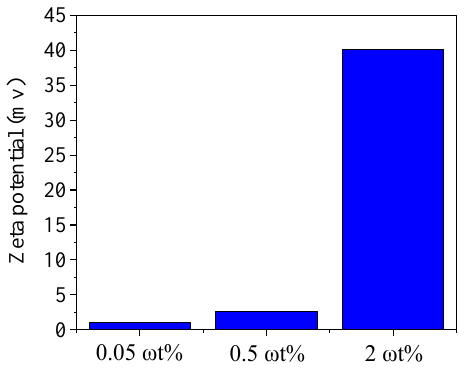
Figure 7. Zeta potential of GO suspensions of different concentrations.